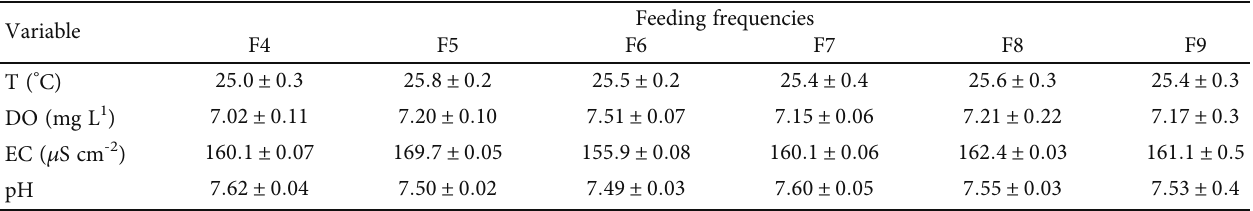
Table 2: Water quality parameters presented as mean ± standard deviation. Temperature (T), dissolved oxygen (DO), electrical conductivity (EC), and hydrogen potential (pH) of the experimental units.